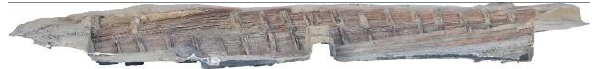
Figure 12. Orthophoto of the plan of the hull in 2014